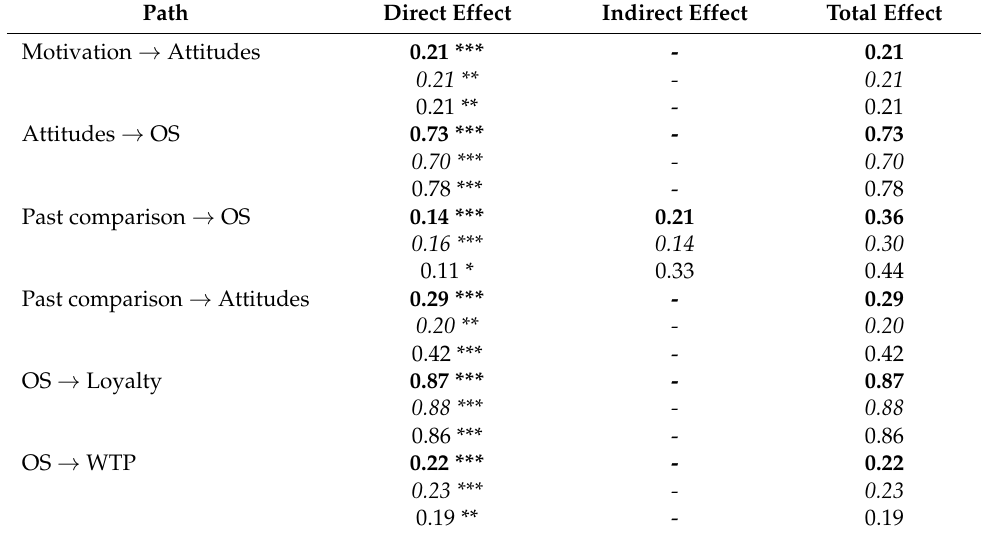
Table 9. Direct effect, indirect effect, and total